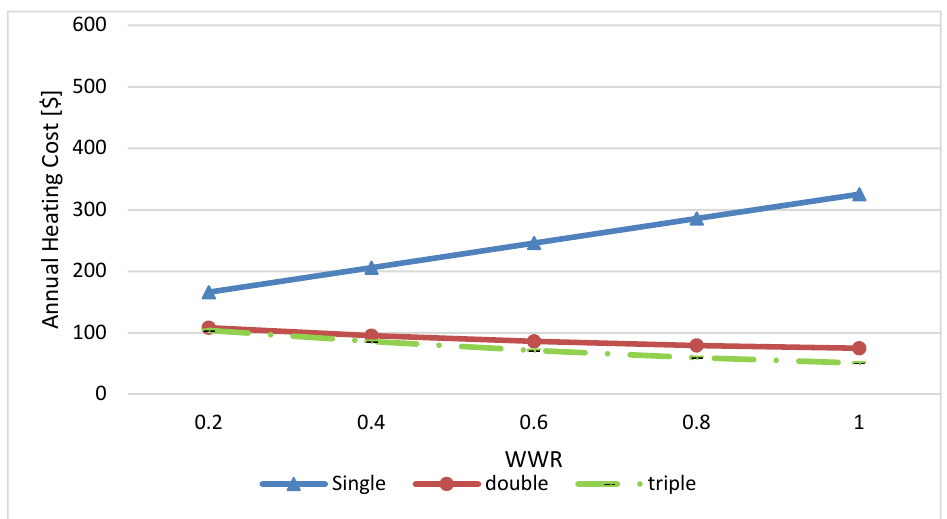
Figure 6. The influence of the window-to-wall ratio on annual heating cost in Istanbul (3 cm insulation, NW oriented).